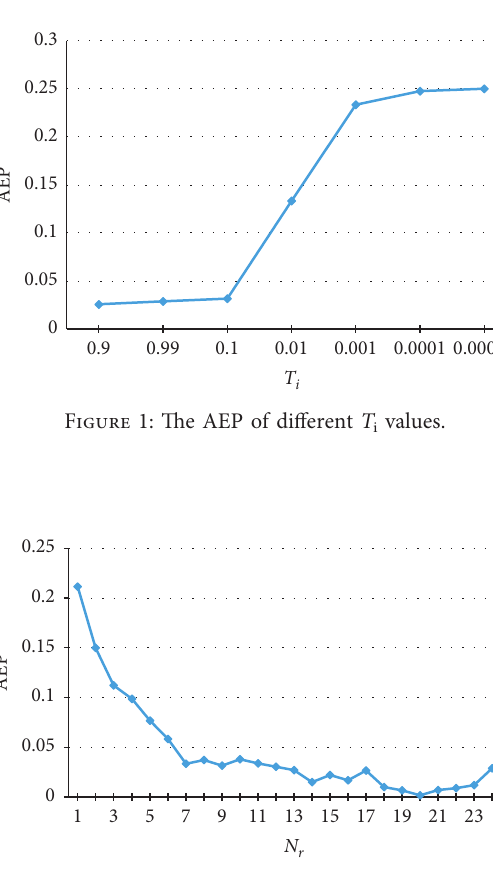
Figure 2: The AEP of different N